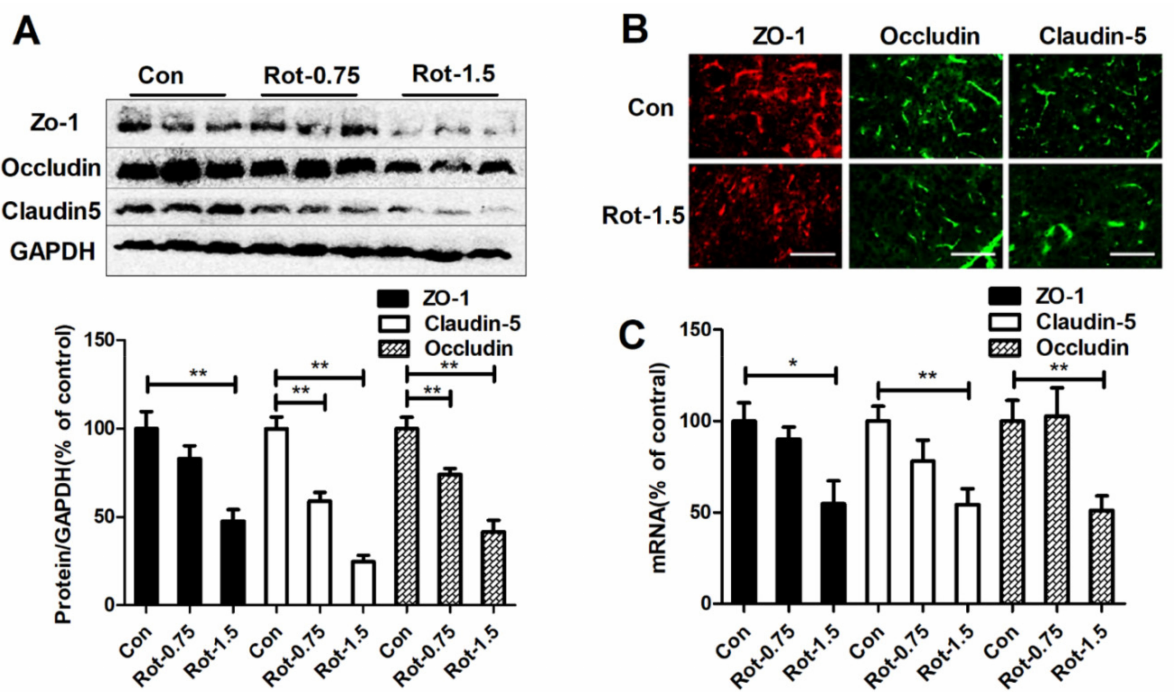
Figure 2. Rotenone dose-dependently reduces expressions and mRNA levels of TJ proteins in mice. ( A ) Representative blots of ZO-1, occludin, and claudin-5 in the midbrain and the quantification of blots. ( B ) Representative images of ZO-1, occludin, and claudin-5 staining in the SN of mice. n = 3. ( C ) Gene expressions of ZO-1, claudin-5, and occludin in the midbrain of mice. n = 6. * p < 0.05, ** p < 0.01; scale bar = 100 µ m. Con: vehicle-treated mice group; Rot-0.75: 0.75 mg/kg/d rotenone- treated mice group; Rot-1.5: 1.5 mg/kg/d rotenone-treated mice